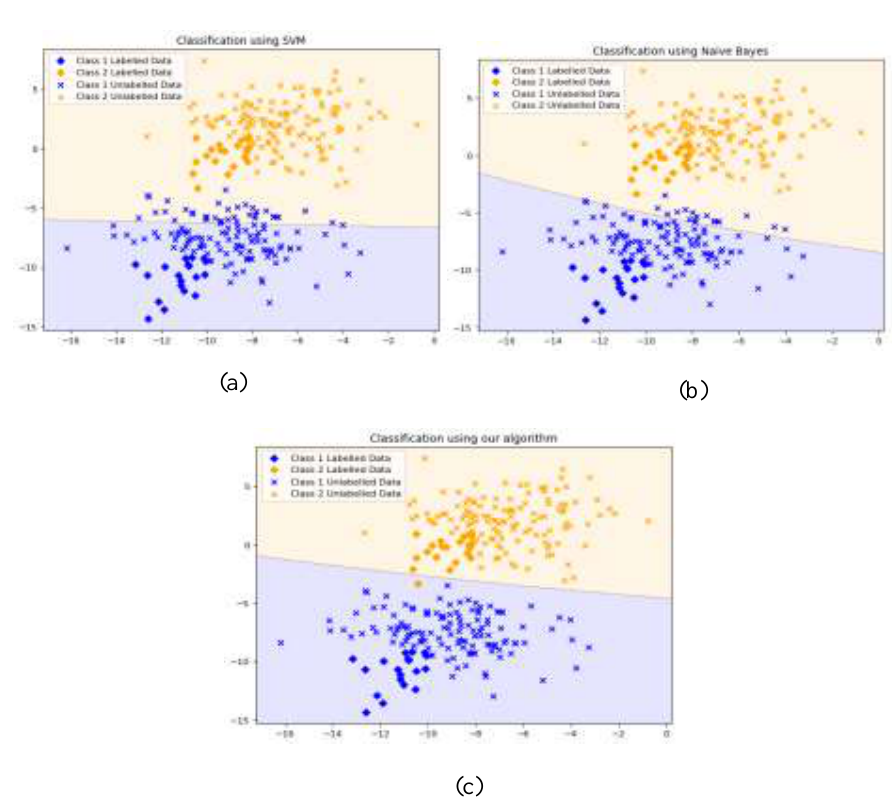
Figure 2. Classification of synthetic data using (a) SVM (b) Naive Bayes (c) SSFBC (Our Proposed